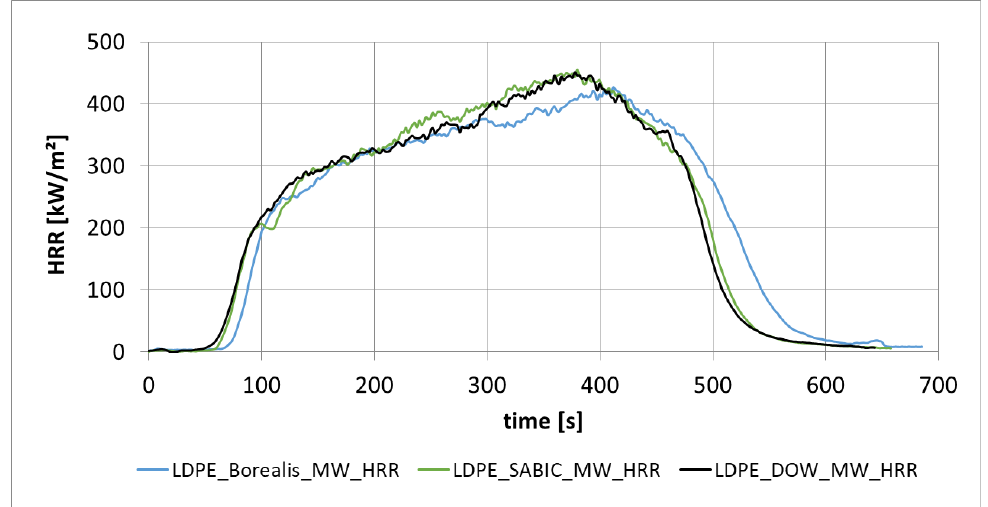
Figure 11. Different heat release rate from different PE-LD manufacturers (Borealis, Sabic, Dow).